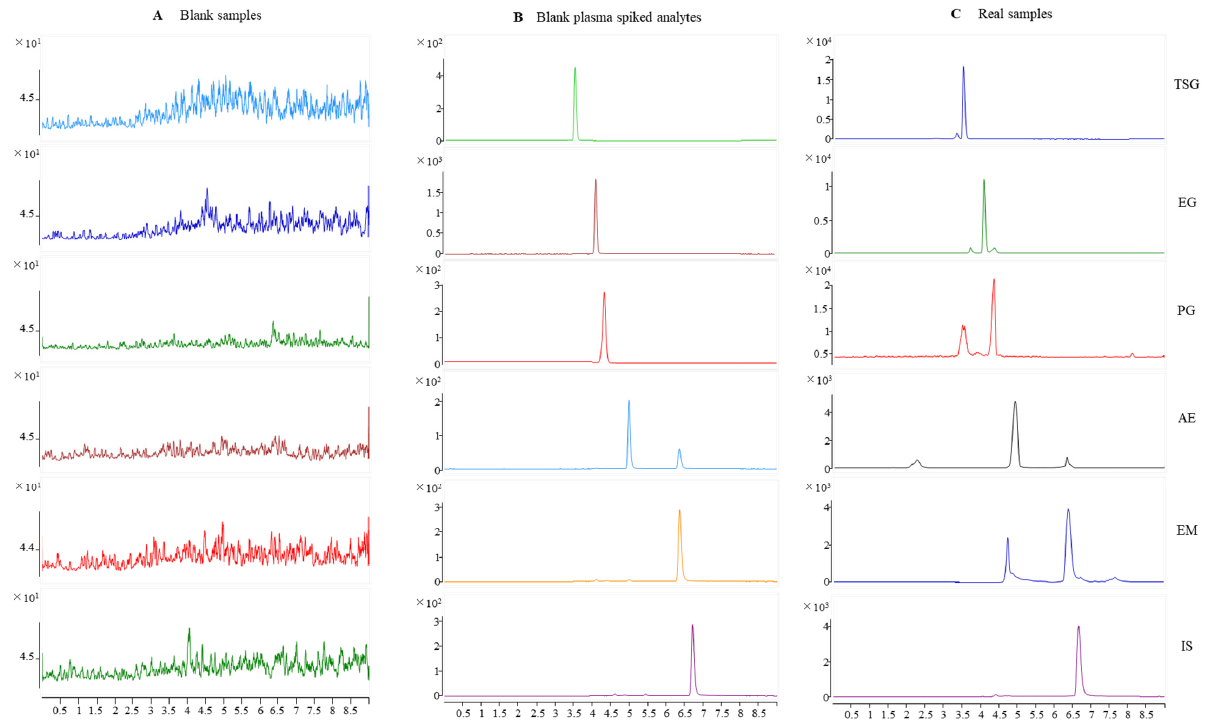
Figure 2. Representative MRM chromatograms for TSG, EG, PG, AE, EM, and IS in rat plasma. ( A ) Blank rat plasma; ( B ) blank rat plasma spiked with TSG, EG, PG, AE, EM, and IS; and ( C ) rat plasma samples after oral administration of PM for 30 min.